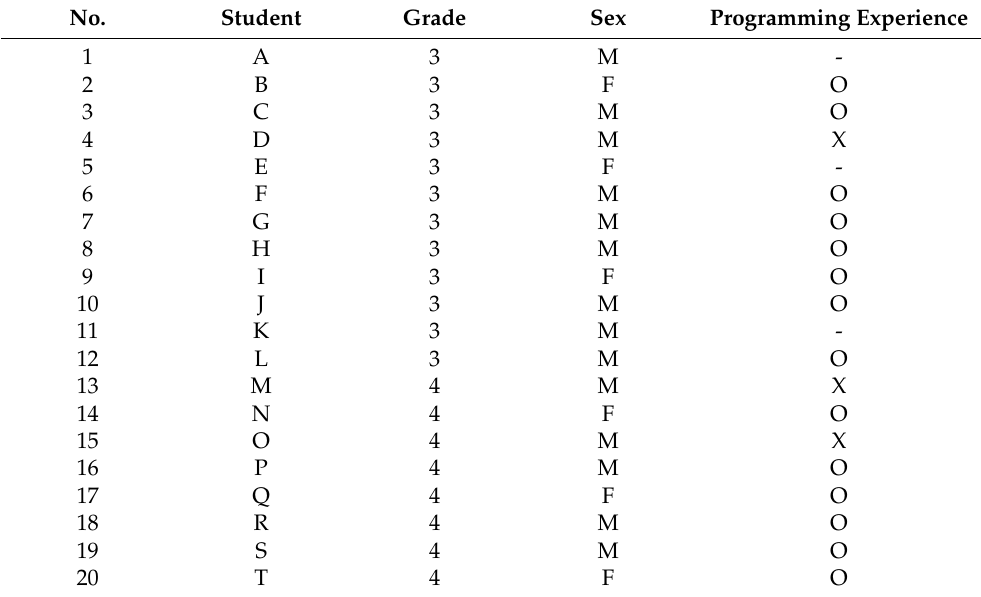
Table 1. Students participating in the experiment and their experience in programming